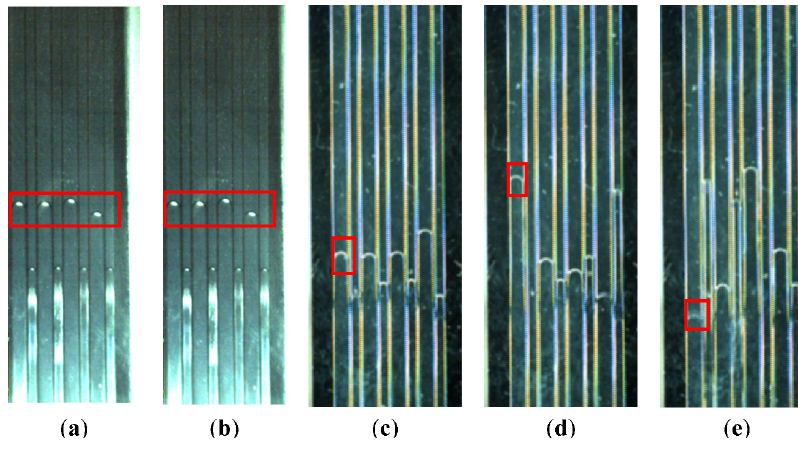
Figure 3. Pictures showing the fluid flow in a horizontally oriented μ PHP having a nonuniform channel at ( a ) 0 s and ( b ) 0.04 s at an input power of 2 W; and at ( c ) 0 s, ( d ) 0.067 s, and ( e ) 0.134 s at an input power of 7